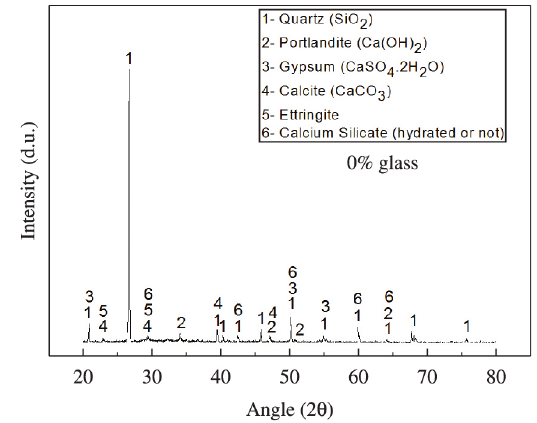
Figure 9. XRD diffractogram of concrete with 0% glass content and a w/c ratio of 0.50.